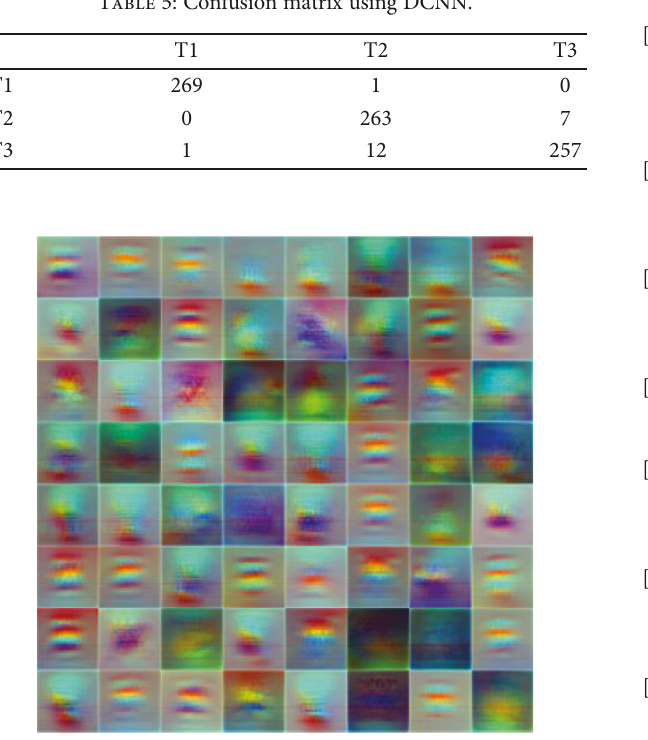
Figure 11: Visualization of learned features in the last convolutional